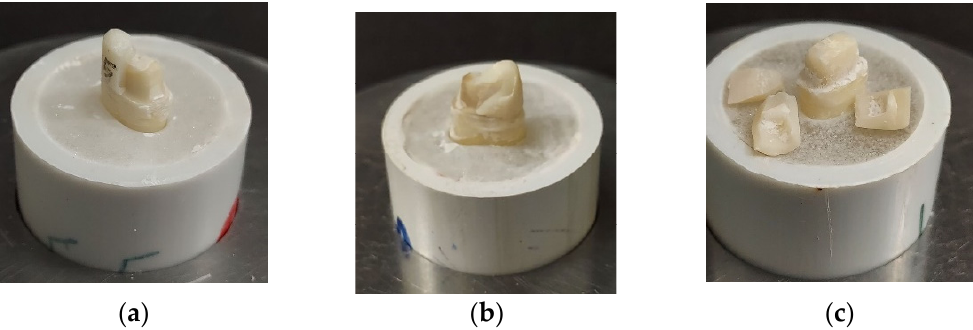
Table 1. Means and standard deviations (SD) for failure loads (MPa) among study groups.